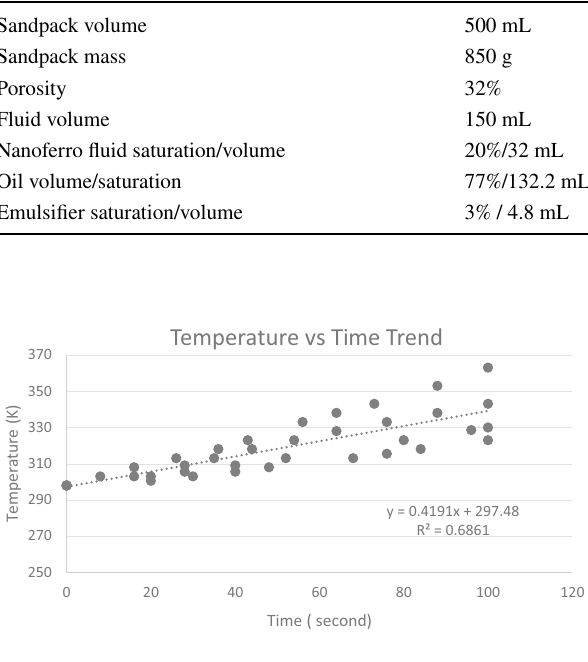
Fig. 5 Temperature alteration vs time at several observation